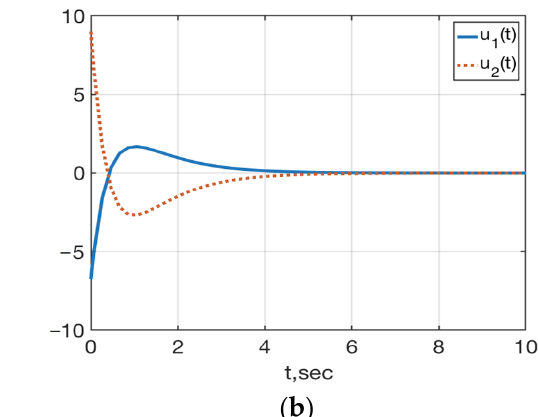
( b ) txtxtx ; ( b ) Plots of )(),( tutu in the closed-loop system (59), (63) Figure 2. ( a ) Plots of x 1 ( t ) , x 2 ( t ) , x 3 ( t ) ; ( b ) Plots of u 1 ( t ) , u 2 ( t ) in the closed-loop system (59), (63) Figure 2. ( a ) Plots of )(),(),( 321 21 with x ( 0 ) = ( 0.5, 0.5, 0.5 ) T with .)5.0,5.0,5.0()0( T = х